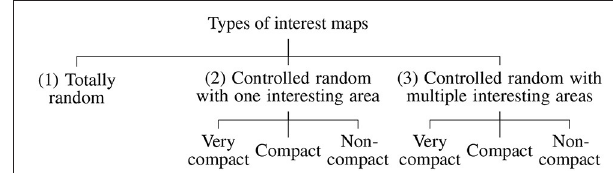
FIGURE 6 | Different types of interest maps.